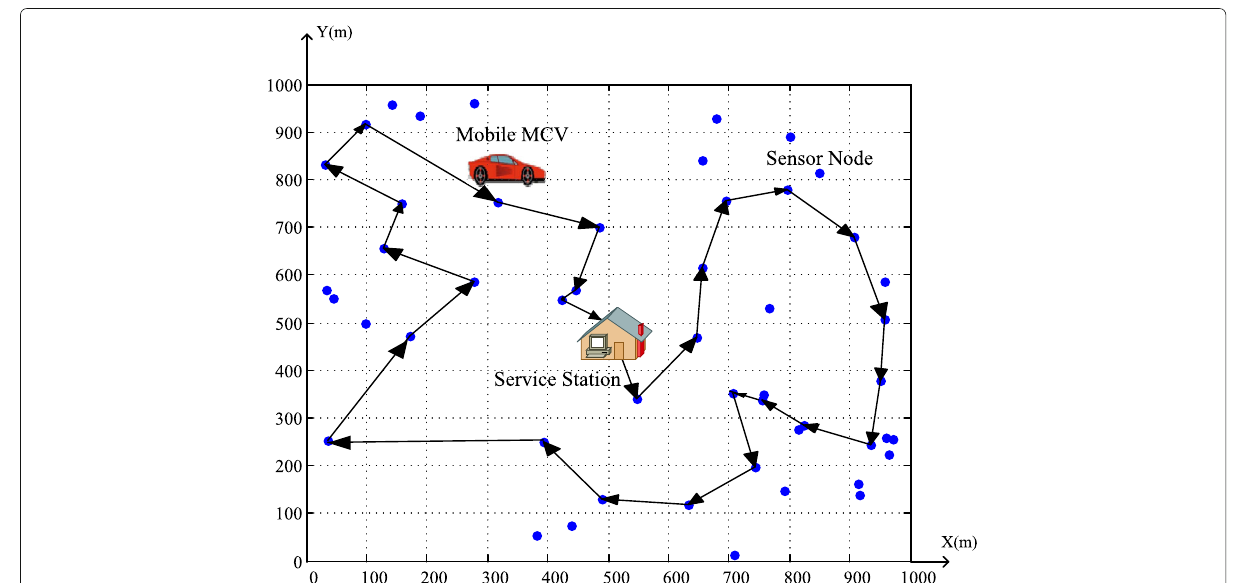
Fig. 5 The energy behavior of the 48th node during two charging periods. The 48th node has the highest power consumption among all nodes in the network. The energy behavior of each node is periodic and can be calculated after the implementation of ERSVC. Similarly, we can also obtain the energy behavior for other nodes. If the remaining energy of a node’s battery is always higher than E min , it will remain operational forever